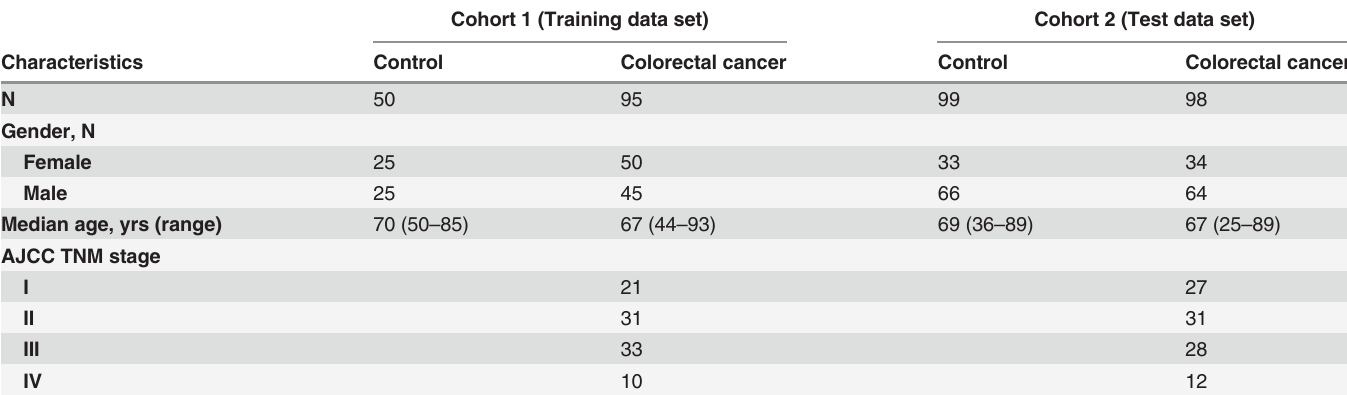
Table 1. Characteristics of the colorectal cancer and normal patients used in this study cohort. Cohort 1 (Training data set)